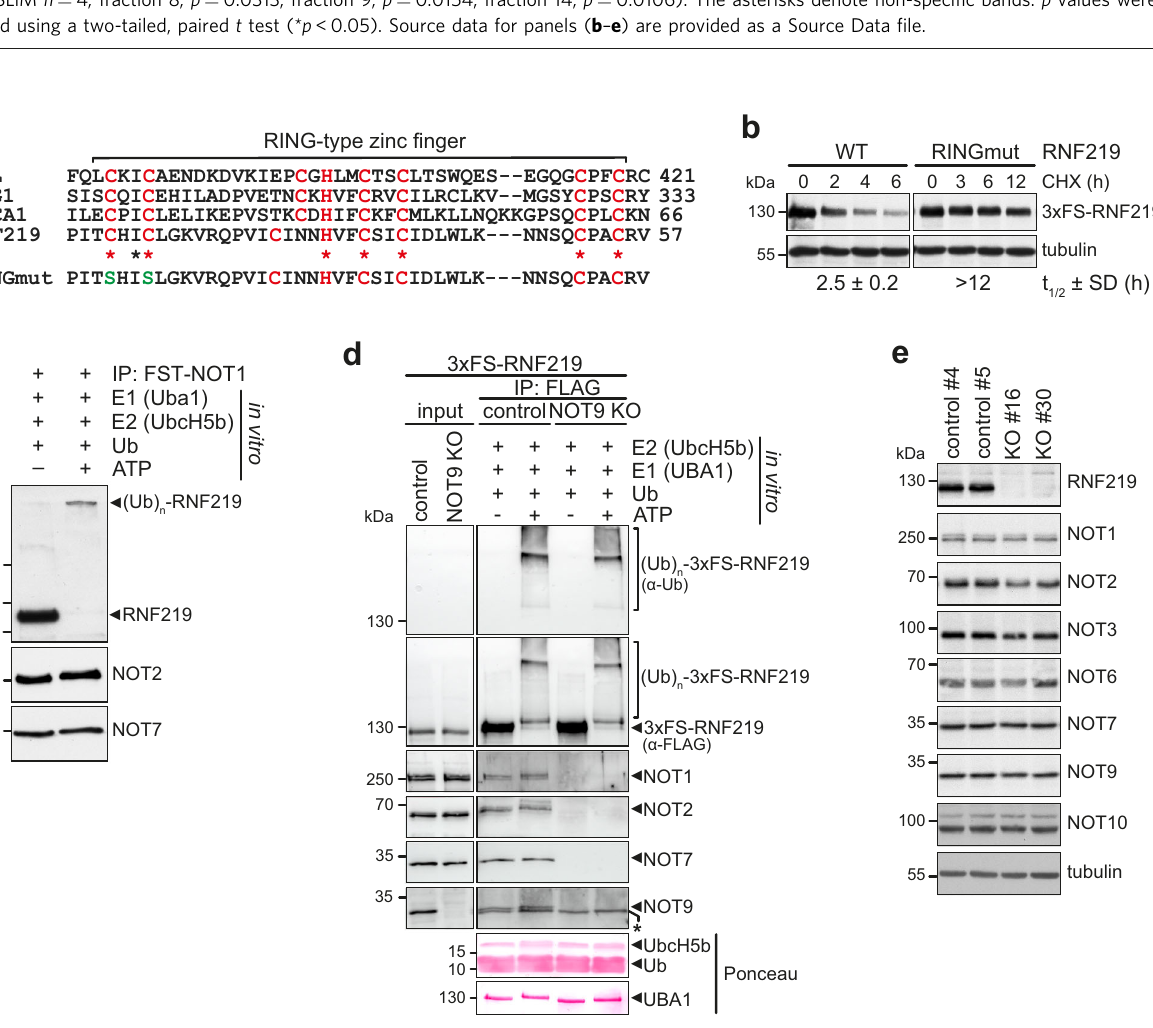
Fig. 3 RNF219 is a CCR4-NOT complex-associated RING-type E3 ligase. a Amino acid sequence alignment of the RNF219 RING domain with other RING- type E3 ligases. Cysteine and histidine residues involved in zinc atom coordination are highlighted in red. Cysteines at position 18 and 21 were mutated to serine in RNF219-RINGmut, shown in green. b Protein stability of 3xFS-RNF219-WT and 3xFS-RNF219-RINGmut was assessed in transiently transfected HeLa cells following translation shut-off with 100 µ M cycloheximide (CHX). Proteins were isolated at regular time intervals and detected by western blot analysis using α -FLAG and α -tubulin antibodies. 3xFS-RNF219-WT and -RINGmut protein half-lives are presented as mean ± SD ( n = 3). c In vitro ubiquitination assay showing autoubiquitination of RNF219 within the endogenous CCR4-NOT complex. Native CCR4-NOT complexes were puri fi ed from HeLa cells expressing FST-NOT1, eluted with 3xFLAG peptide, and incubated with recombinant E1 enzyme (UBA1), E2 enzyme (UbcH5b) and ubiquitin in the absence or presence of 5 mM ATP. Reaction products were detected by western blot analysis as indicated. d In vitro ubiquitination assay showing autoubiquitination of RNF219 in the presence and absence of the CCR4-NOT complex. CCR4-NOT complexes were puri fi ed from CRISPR control or NOT9 KO HeLa cells stably expressing 3xFS-RNF219 by FLAG IP and used for in vitro ubiquitination assays as described in ( c ). The asterisk denotes a non-speci fi c band. e Total protein lysates derived from two control and two RNF219 KO HeLa clones were analyzed by western blotting using antibodies as indicated. Source data for panels ( b – e ) are provided as a Source Data fi